Question: Provide a one-line summary of what is displayed.
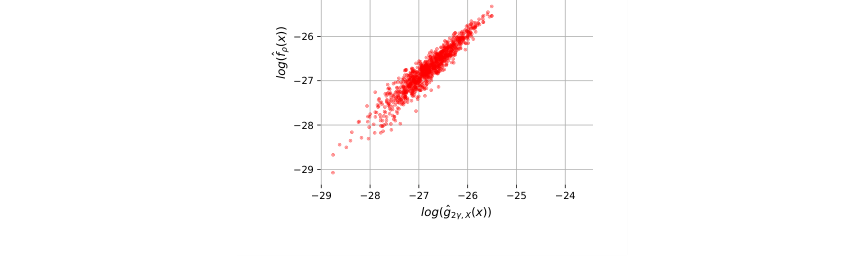
Answer: Scatter-plots comparing the log density predicted by KDE and DMKDE: test sam- ples (top left), uniformly random generated samples (top right), both test and random samples (bottom).